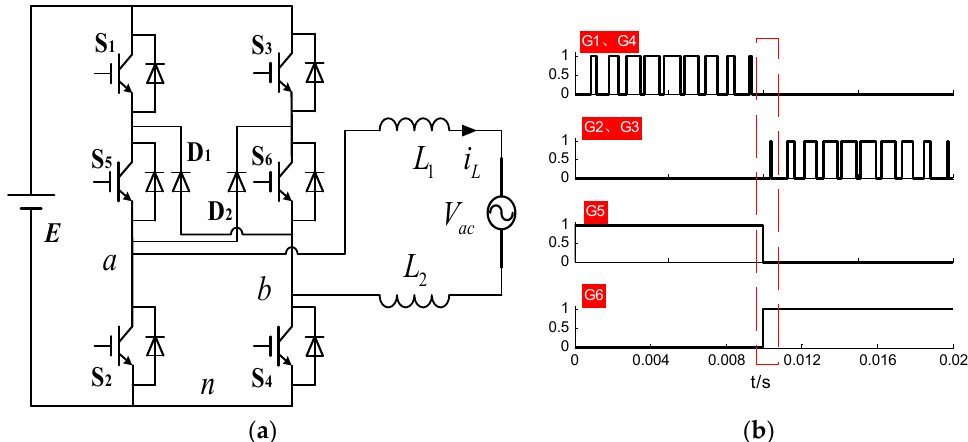
Figure 1. Structure of H6 and modulation mode I. ( a ) H6 grid-tied inverter topology, ( b ) modulation mode I (MMI).